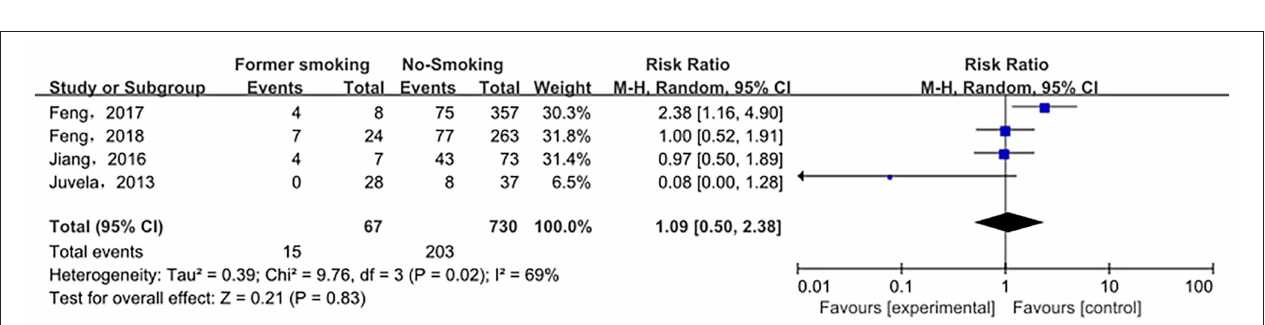
former smokers, 2,422 non-smokers, and 3,014 ruptured IA. The characteristics of the studies included in this meta-analysis are shown in Table 1